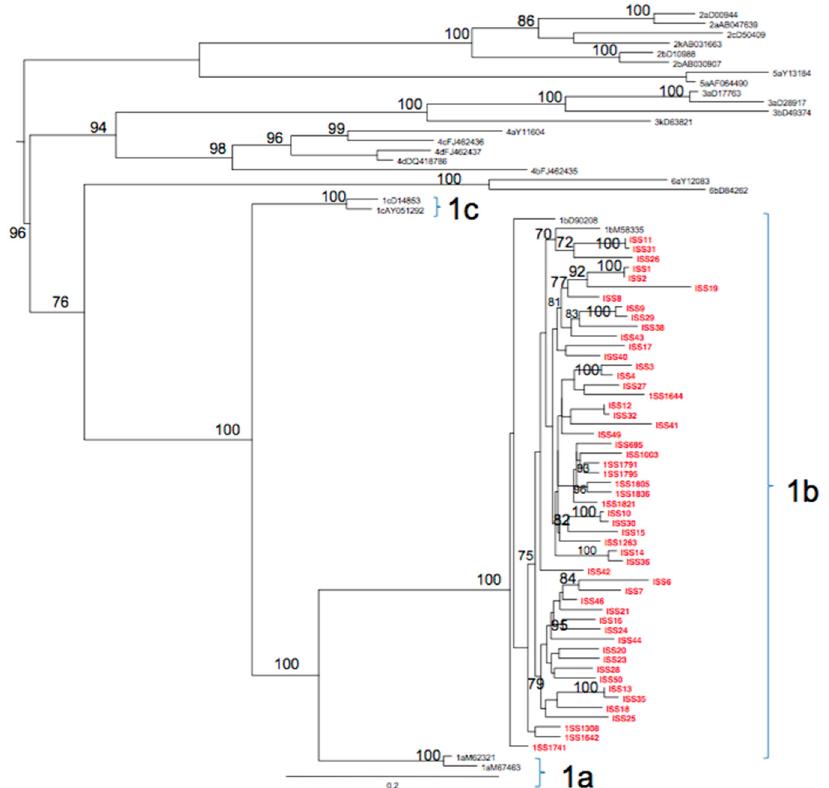
Figure 1. Maximum likelihood phylogenetic tree of the first HCV NS5B dataset. The tree was rooted by using the midpoint rooting method. Branch lengths were estimated with the best fitting nucleotide substitution model according to a hierarchical likelihood ratio test, and were drawn to scale with the bar at the bottom indicating 0.2 nucleotide substitutions per site. The values along a branch represent significant statistical support for the clade subtending that branch (bootstrap support >75%). The Italian (Calabria Region) sequences are highlighted in red. Clades 1b, 1c and 1a are also highlighted with brackets.